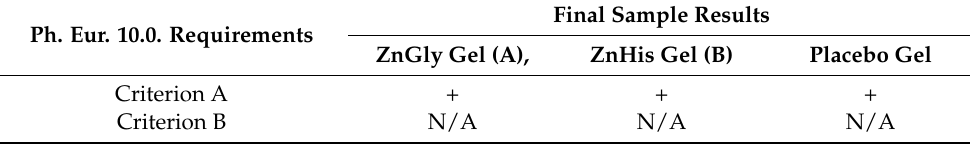
Table 6. The obtained results from the efficacy of antimicrobial preservation